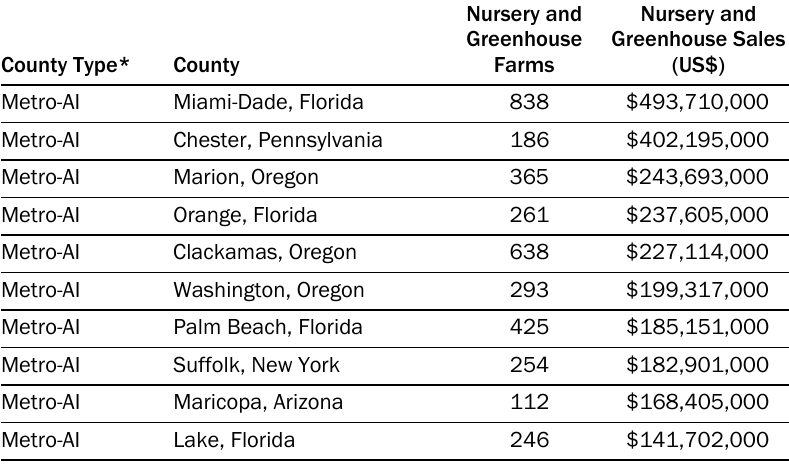
Table 4. Top 10 Nursery and Greenhouse Counties by Sales Without